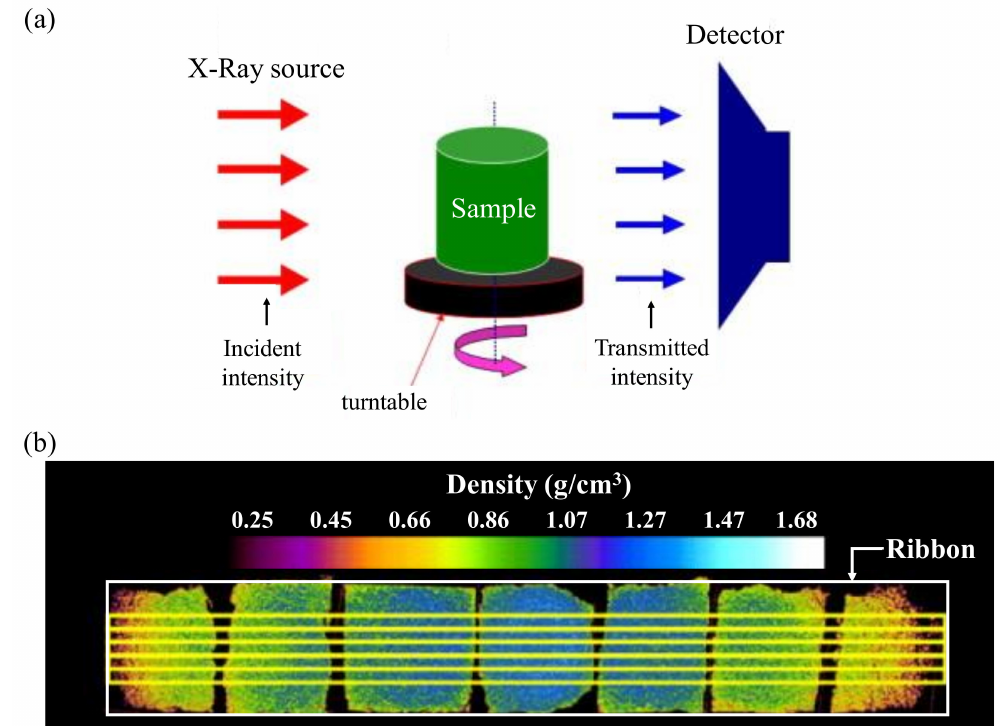
Figure 17. Photo-montage of integrated X-ray micro-CT images [160]: ( a ) measurement principle; ( b ) integrated micro-CT images of the ribbon samples. The figures were slightly modified, with permission from